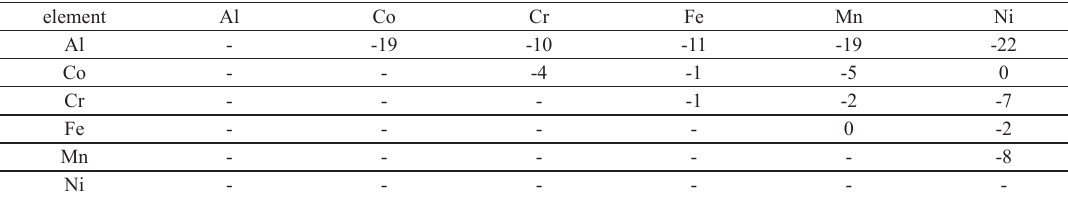
Table 4. Mixing enthalpy parameter between binary ( KJ/mol). element